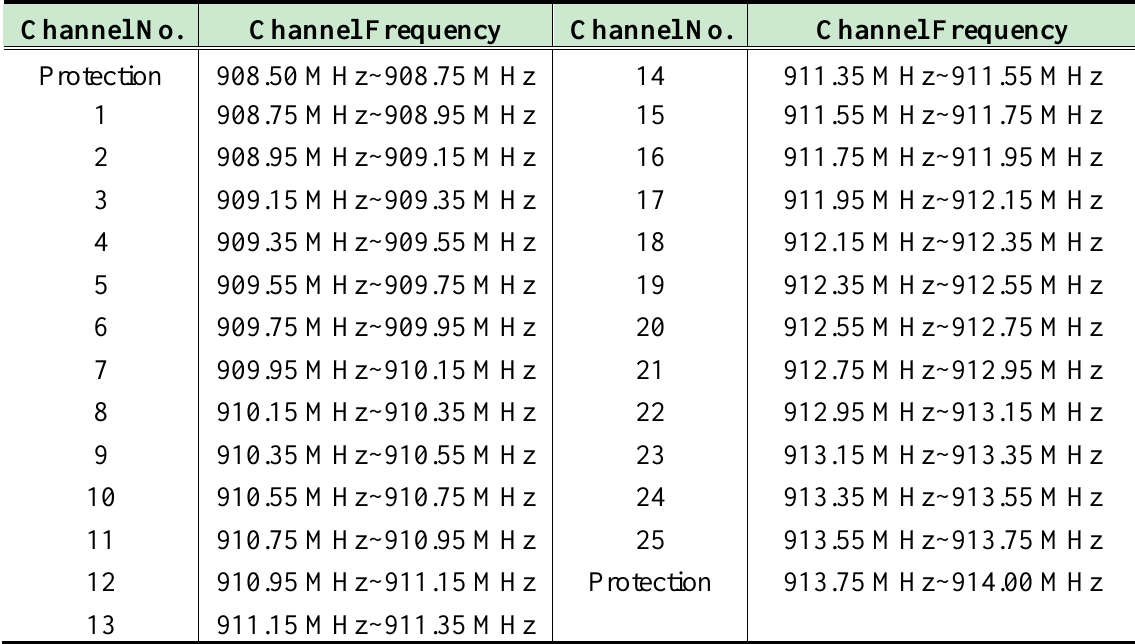
Table 1. Channel numbers and bandwidths for mobile RFID in Korea.